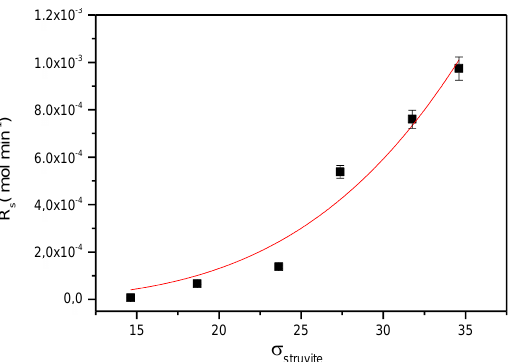
Figure 4. Dependence of the rate of spontaneous precipitation of struvite from supersaturated solutions on the relative supersaturation with respect to struvite. Method A: Brucite suspension magnesium source; 25 °C.